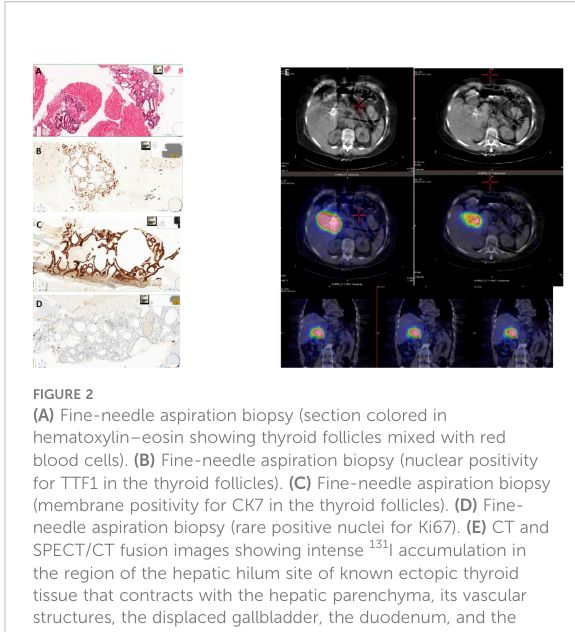
FIGURE 2 (A) Fine-needle aspiration biopsy (section colored in hematoxylin – eosin showing thyroid follicles mixed with red blood cells). (B) Fine-needle aspiration biopsy (nuclear positivity for TTF1 in the thyroid follicles). (C) Fine-needle aspiration biopsy (membrane positivity for CK7 in the thyroid follicles). (D) Fine- needle aspiration biopsy (rare positive nuclei for Ki67). (E) CT and SPECT/CT fusion images showing intense 131 I accumulation in the region of the hepatic hilum site of known ectopic thyroid tissue that contracts with the hepatic parenchyma, its vascular structures, the displaced gallbladder, the duodenum, and the head of the